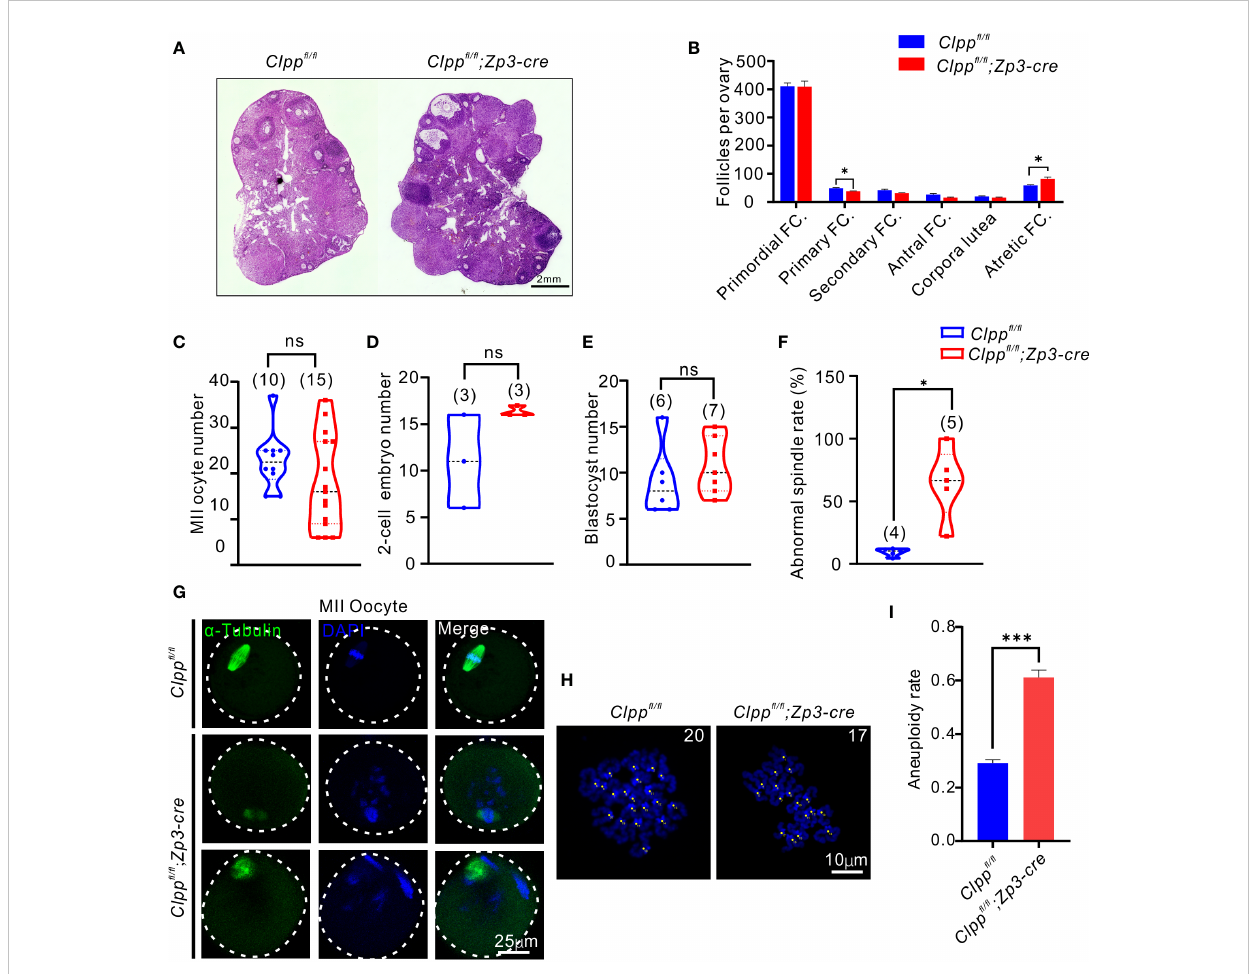
FIGURE 2 Clpp fl / fl ; Zp3 -Cre cKO female mice exhibits oocyte meiotic defects. (A) Ovarian histomorphological analysis in 8-week-old Clpp fl / fl ; Zp3 -Cre cKO and control female mice. (B) Follicle counts were performed using three biological replicates for each group(n=3). (C) Mature (MII) oocyte, (D) two- cell embryo, and (E) blastocyst generation in 8-week-old control and Clpp fl / fl ; Zp3 -Cre cKO female mice. (F) Representative spindles from Clpp fl / fl ; Zp3 -Cre and control MII oocyte obtained in vivo . Column 1, anti-a-tubulin antibody (green); Column 2, DAPI (blue); Column 3, merged images of DAPI and anti-a-tubulin. (G) Percentage of Clpp fl / fl ; Zp3 -Cre and control MII oocyte with abnormal chromosome alignment on spindle. (H) Chromosome staining of Clpp fl / fl ; Zp3 -Cre and control MII oocytes with DAPI and (I) ratio of chromosomal aneuploidy. All the oocyte and ovary samples were from 8-week-old female mice. N.S. means no signi fi cant difference; * p < 0.05; *** p < 0.001. The results represent mean ± SEM. Signi fi cance was determined by Student t